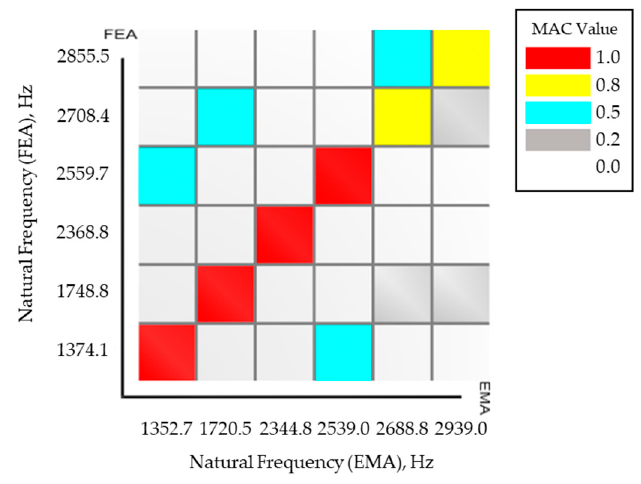
Figure 6. Modal assurance criterion (MAC) results between the experimental modal analysis (EMA) and finite element analysis (FEA).